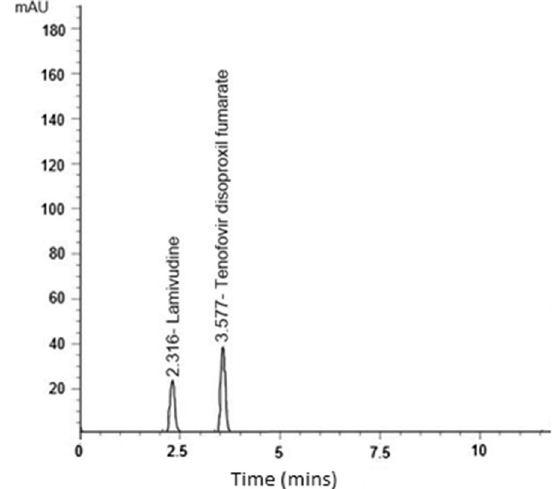
Fig. 5 Chromatogram of mixed standards of lamivudine and tenofovir disoproxil